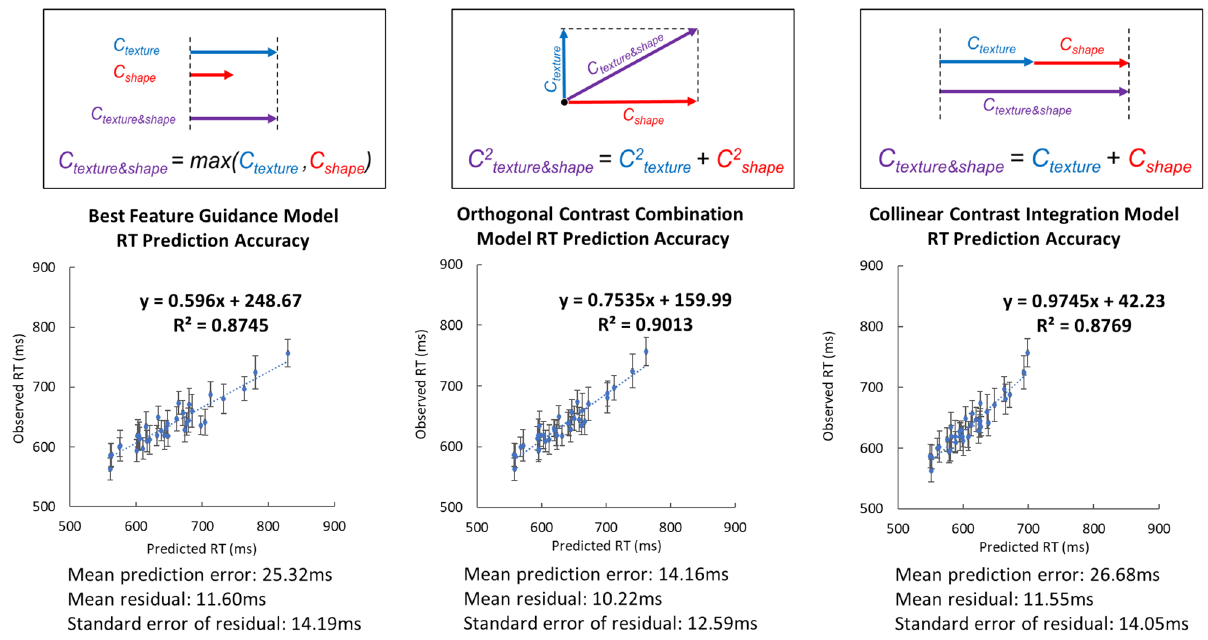
Figure 5. Top Visualization of how contrasts along texture ( C texture ) and along shape ( C shape ) could be combined to produce the overall contrast when a target differs from distractors along two feature dimensions ( C texture & shape ) according to the Best Feature Guidance Model (left panel), the Orthogonal Contrast Combination Model (middle panel), and the Collinear Contrast Integration Model (right panel), respectively. Bottom Observed RTs from Experiment 2A–C as a function of Predicted RTs. Predicted RTs were estimated using Eq. (5). The left, middle, and right panels show the prediction accuracy of Eq. (5) when the D overall parameter was computed based on the Best Feature Guidance Model (Eq. (6)), the Orthogonal Contrast Combination Model (Eq. (7)), and the Collinear Contrast Integration Model (Eq. (8)), respectively. Error bars on each data point indicate the standard error of the observed reaction time for each specific